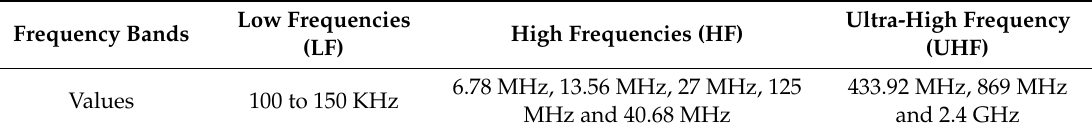
Table 3. Distribution ISM bands.